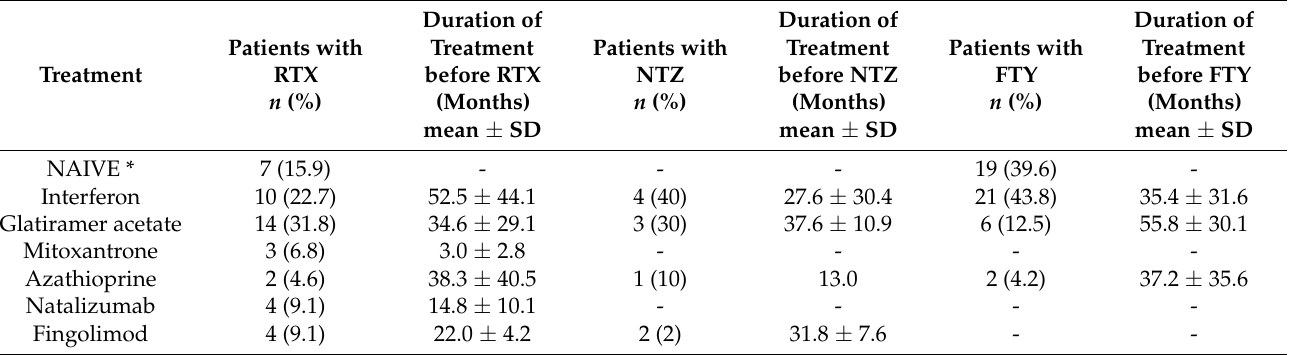
Table 2. Treatment before the initiation of RTX.